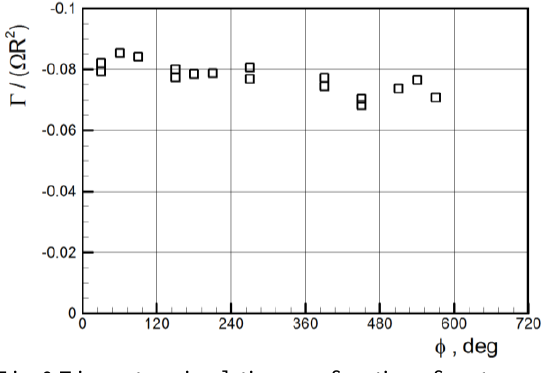
Fig. 9 Tip vortex circulation as a function of vortex